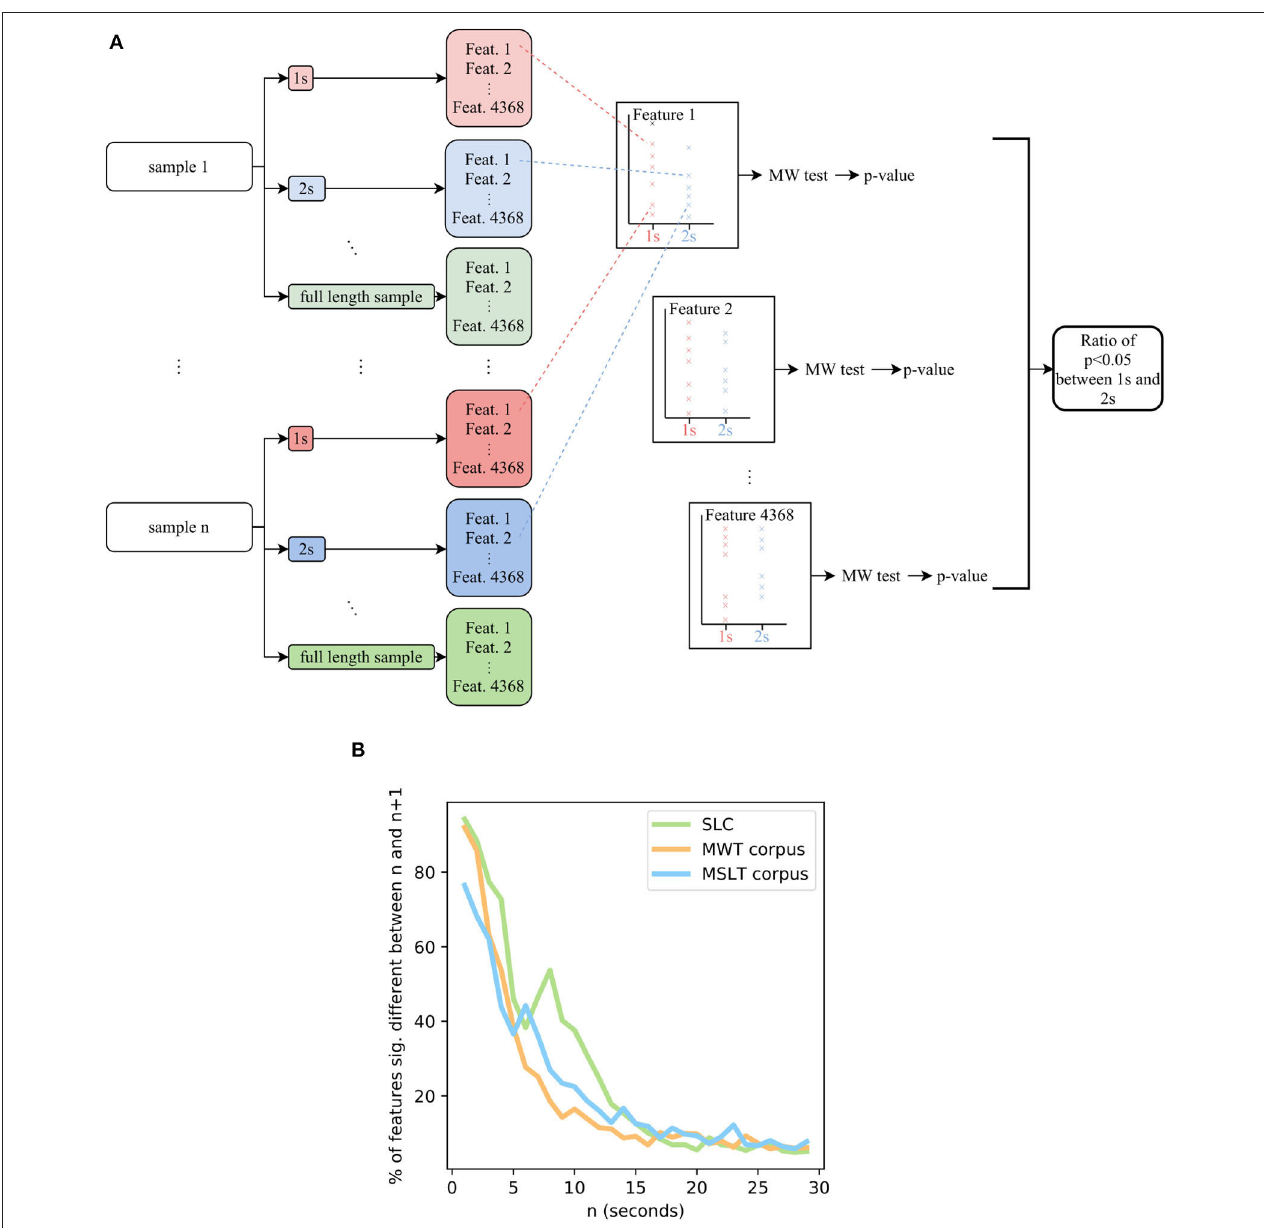
FIGURE 8 | (A) Flowchart of the system aiming at estimating the length of minimal audio samples for the computed features to converge. (B) The ratio of features having converged depending on the length of the samples, on the SLC, MWTc, and MSLTc. MW , Mann-Whitney’s U.